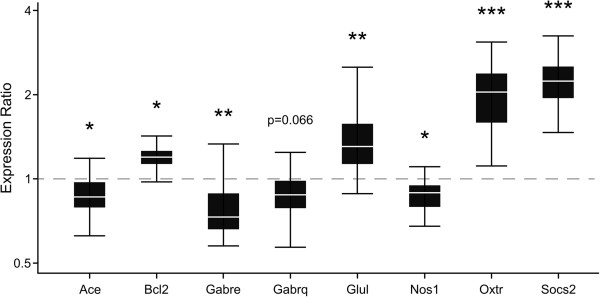
Significant and near-significant qPCR results for a subset of genes differentially expressed in the MPOA. The relative expression (y-axis) represents a ratio of gene expression in postpartum versus virgin females, using Hmbs and Hprt as reference genes. Ratios over one indicate genes with higher expression values in postpartum females, while ratios less than one indicate genes with lower expression values in postpartum females. The box whisker plots demarcate the range (whiskers), interquartile range (box), and median (solid white line) for each gene tested. In confirmation of microarray results, Ace, Gabre, and Nos1 were significantly down-regulated in lactating females, and Bcl2, Glul, Oxtr, and Socs were significantly up-regulated in lactating females. While Gabrq was significantly down-regulated in microarray results, there was a trend toward significance in qPCR results. *p < 0.05; **p < 0.01; ***p < 0.001.